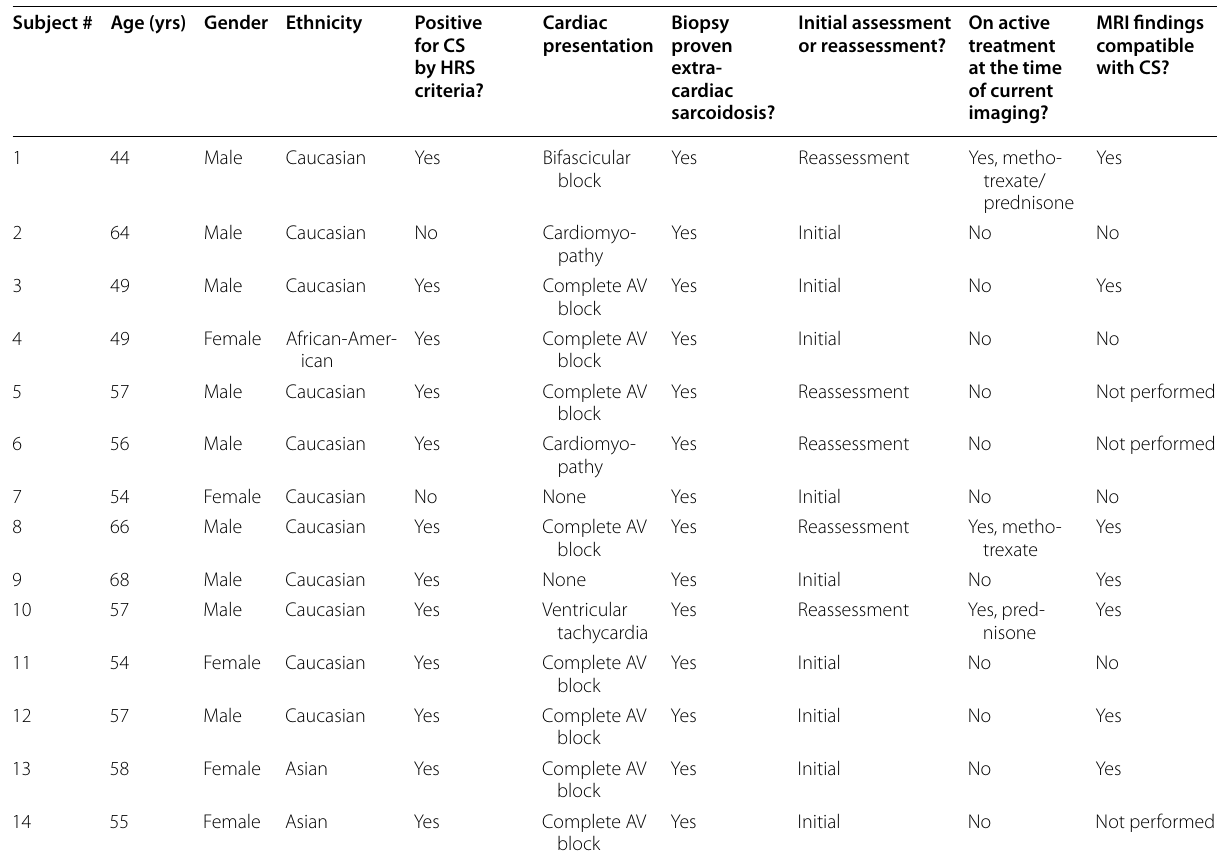
Table 1 Subject baseline characteristics Subject # Age (yrs) Gender